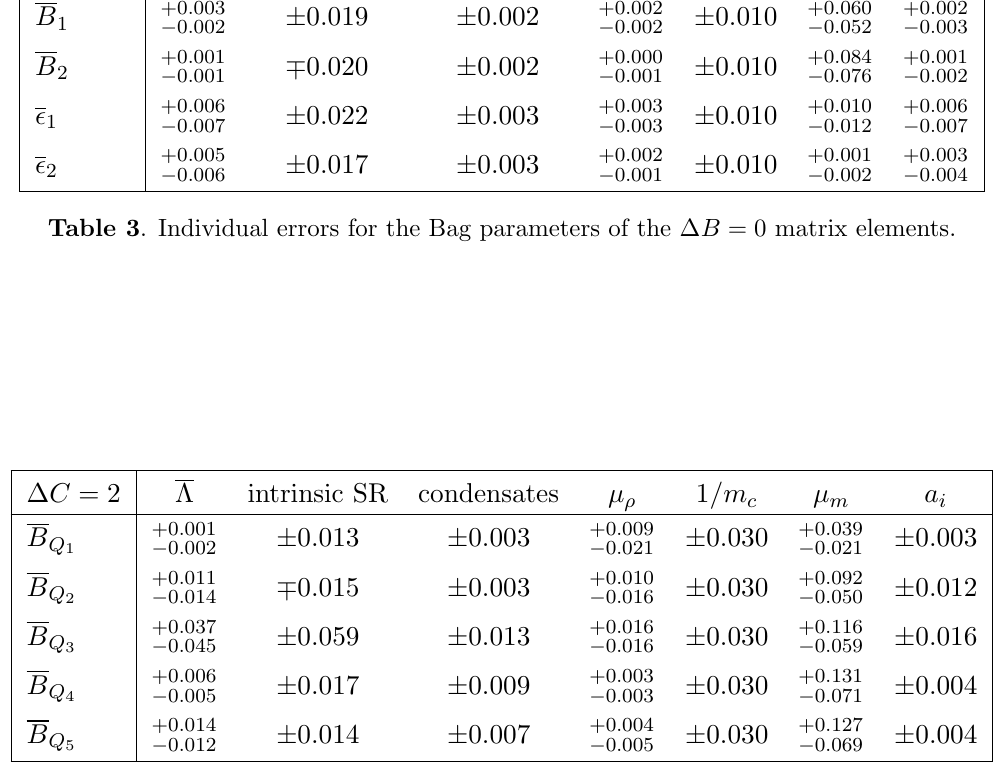
Table 4 . Individual errors for the Bag parameters of the (cid:1) C = 2 matrix elements.